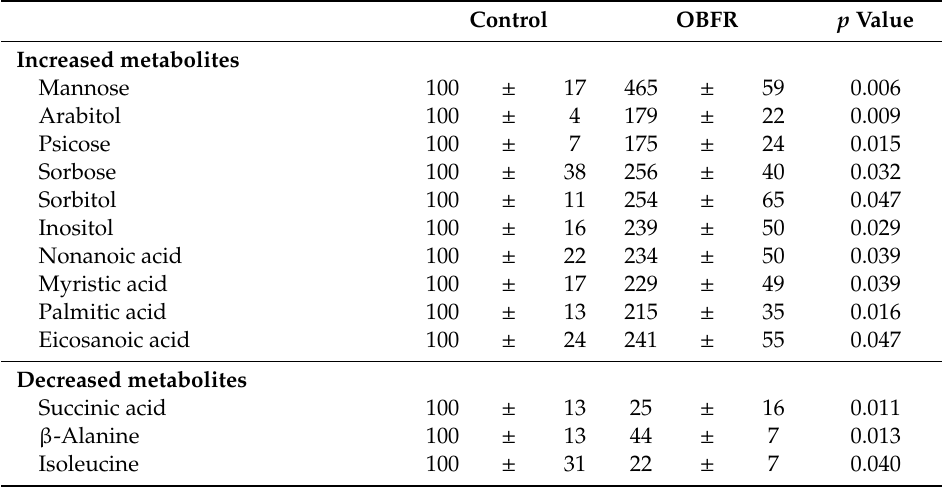
Table 5. E ff ects of feeding OBFR on metabolites in plasma of rats.